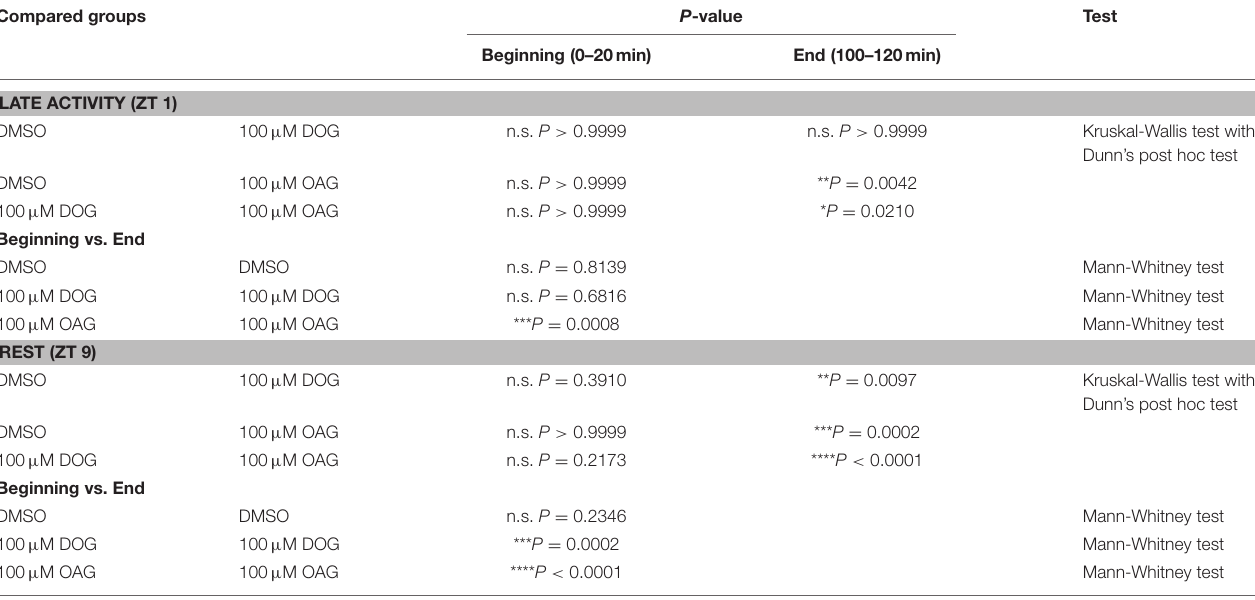
TABLE 1 | Statistical analysis of the normalized SPA in the presence or absence of 100 µ M DOG or OAG during the late activity phase and at rest ( Figure 2 ). Compared